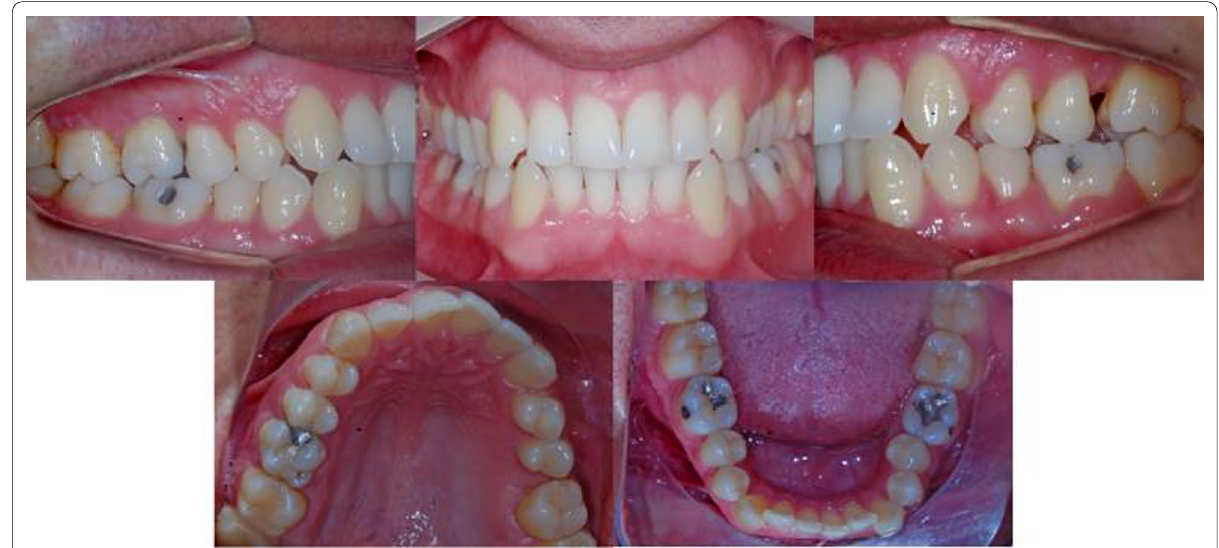
Fig. 1 Pretreatment photographs of an adult patient with one permanent first molar